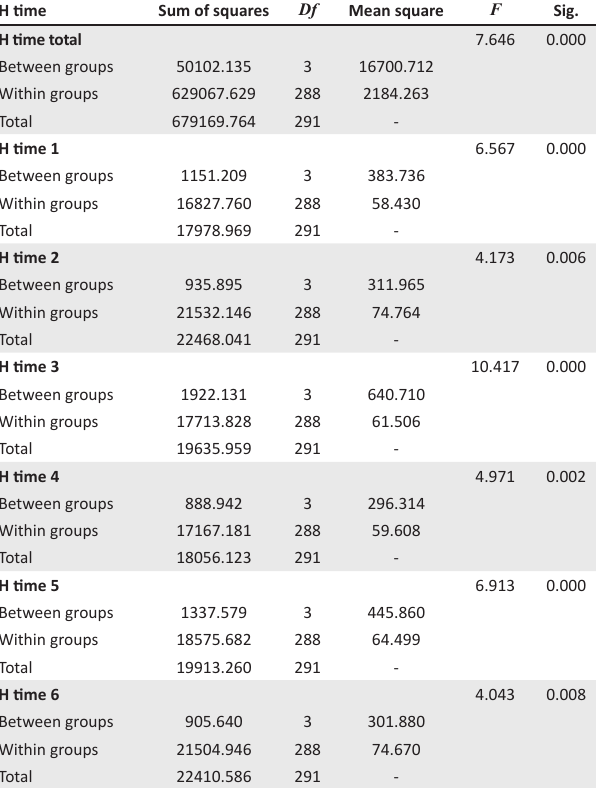
TABLE 6: ANOVA: Comparison of time scores for age groups on the CE letter cancellation